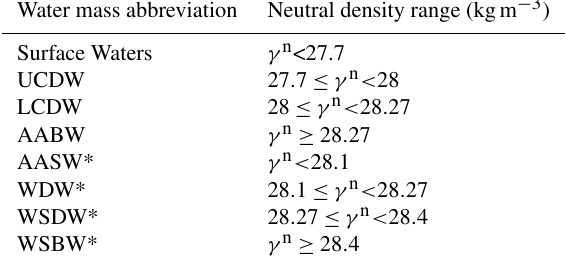
Table 1. Neutral density surfaces limiting each water mass consid- ered in the study. The asterisk (*) denotes the water mass definitions only applicable in the Weddell Sea